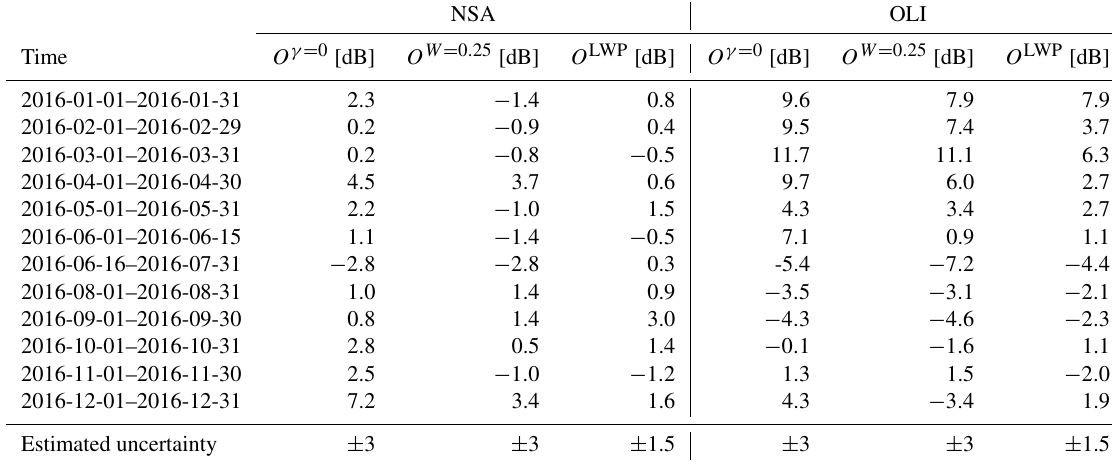
Estimated uncertainty ± 3